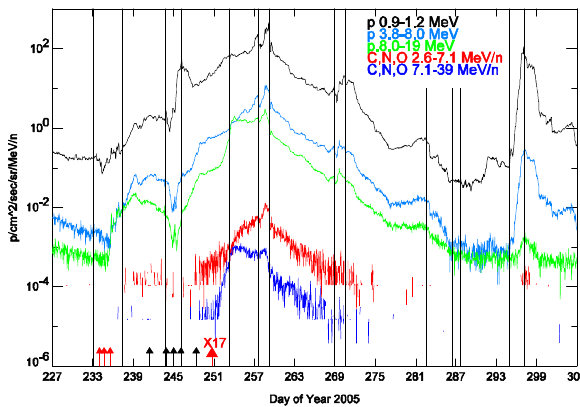
Figure 2. From top to bottom: Overview of the 0.9-1.2 MeV, 3.8-8.0 MeV and 8.0-19.0 MeV Fig. 2. From top to bottom: Overview of the 0.9–1.2MeV, 3.8– energetic proton intensities and the heavy ion intensities in the 2.6-7.1 MeV/n and 7.1-39 8.0MeV and 8.0–19.0MeV energetic proton intensities and the heavy ion intensities in the 2.6–7.1MeV/n and 7.1–39MeV/n en- MeV/n energy intervals for the charge group C,N,O as measured by the Ulysses ergy intervals for the charge group C,N,O as measured by the COSPIN/LET instrument during the period presented in Figure 1. Ulysses COSPIN/LET instrument during the period presented in Fig.